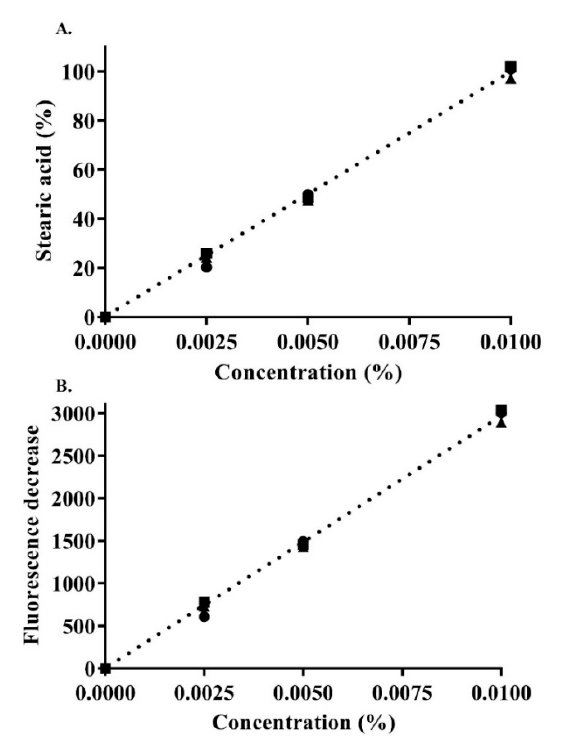
Figure 6. Concentration-dependent SA calibration curve: SA percentage ( A ) as a function of the decrease in fluorescence ( B ) in 0.1 mM phosphate buffer (pH 6.8) containing 0.001% fluorescein. Indicated values are the means ± SD ( n ≥ 3).